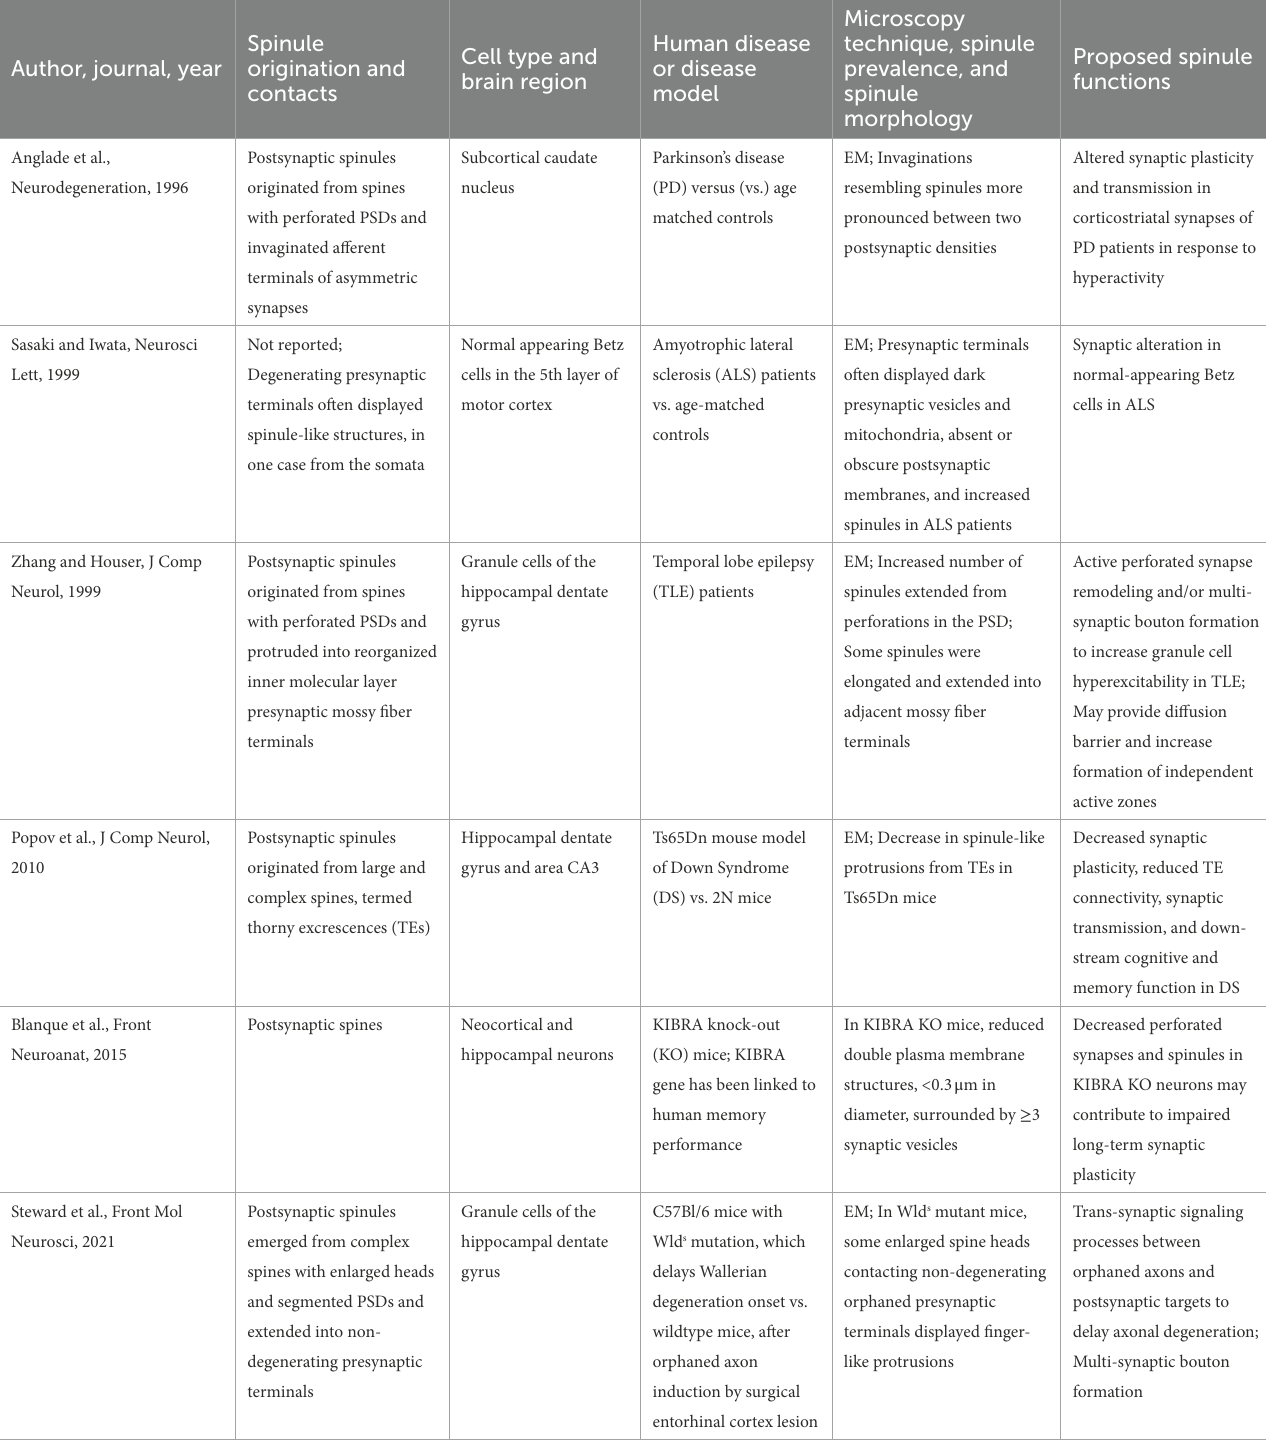
TABLE 2 Spinule structure and proposed functions in psychiatric